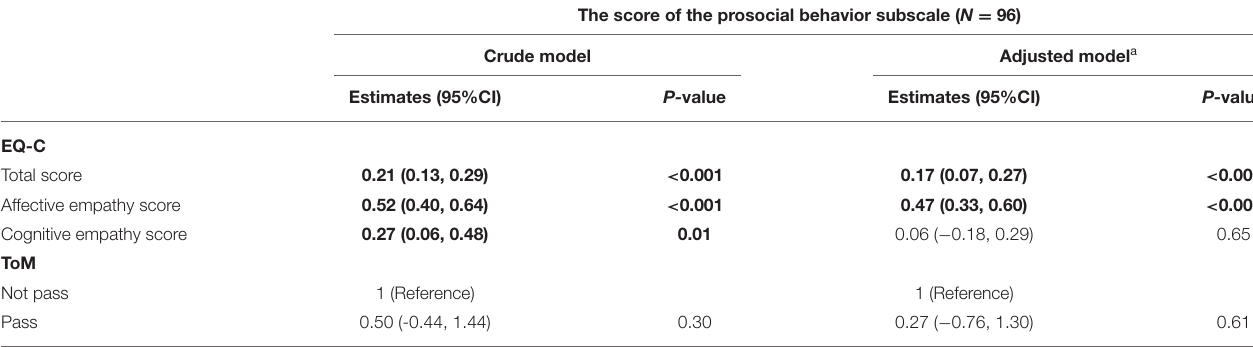
TABLE 2 | Associations between empathic traits, ToM ability and parent-reported prosocial behaviors in autistic children. The score of the prosocial behavior subscale ( N = 96)